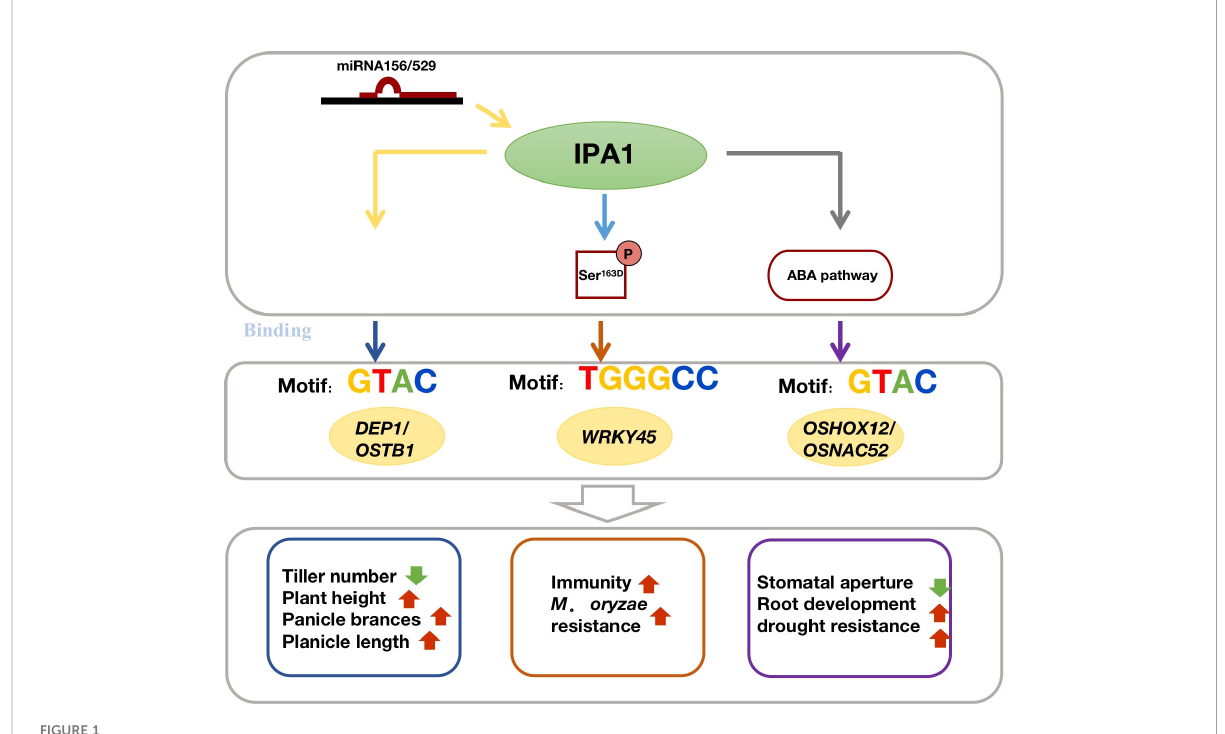
FIGURE 1 Regulatory relationship of IPA1 on plant architecture and stress